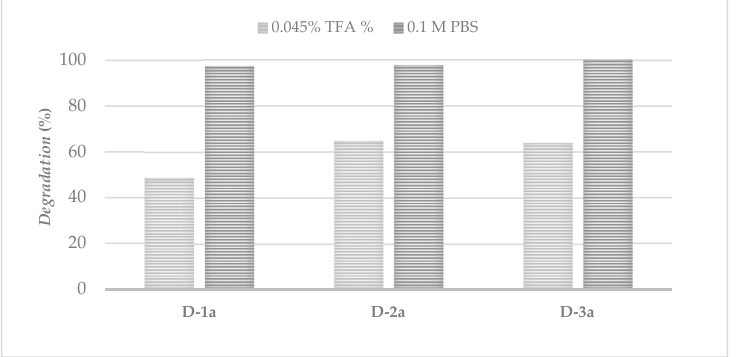
Figure 13. Percentage of degradation of ferrocene peptides in 0.045% TFA and 0.1 M buffer after 24 h.